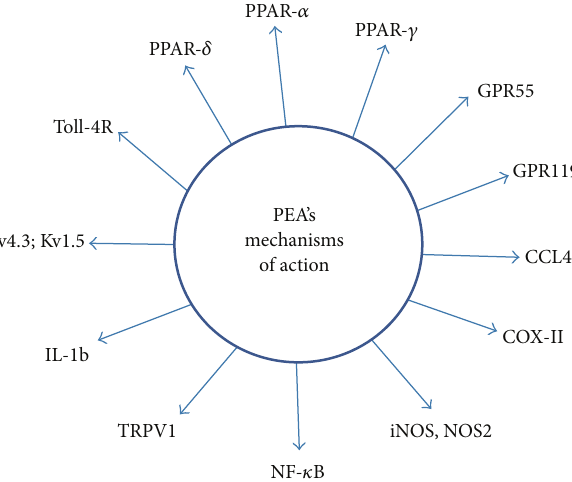
Figure 1: Different molecular targets of PEA. PPAR: peroxisome proliferator activated receptor; GPR-55: 119-orphan G-protein cou- pled receptors; CCL: chemokine ligand; COX: cyclooxygenase; iNOS: inducible nitric oxide synthase; TRPV: transient receptor potential cation channel subfamily V; IL: interleukin; Kv1.5,4.3: potassium voltage gated channels; Toll-4 R: toll-like